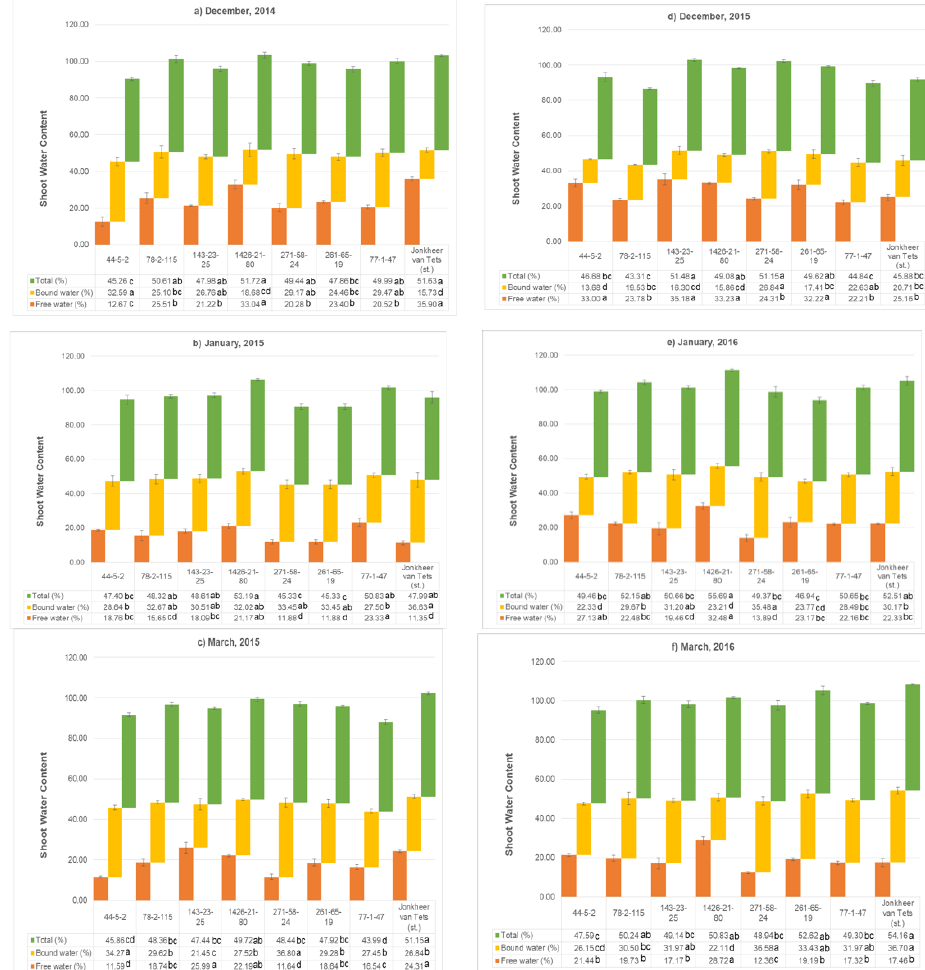
Figure 4. Shoot water content (free water, bound water, and total; %) of the shoots of selected genotypes during dormant period. (Letters next to the values in figure table are used to compare genotypes separately for measured parameters. Different letters shown represent significant difference among the values according to Tukey’s HSD test).